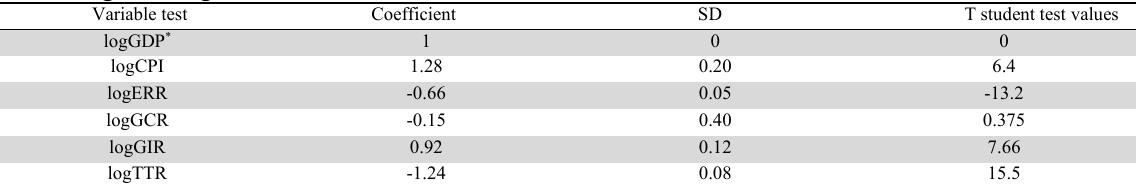
Estimating convergence